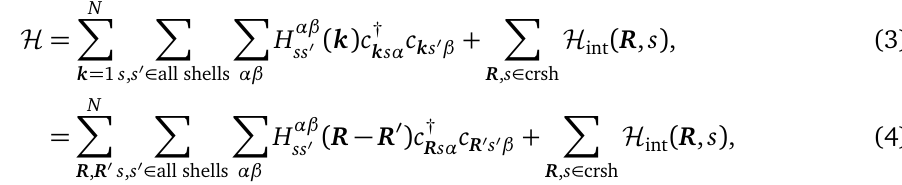
− 1 . 〈 ... 〉 denotes an average over the k 0 G